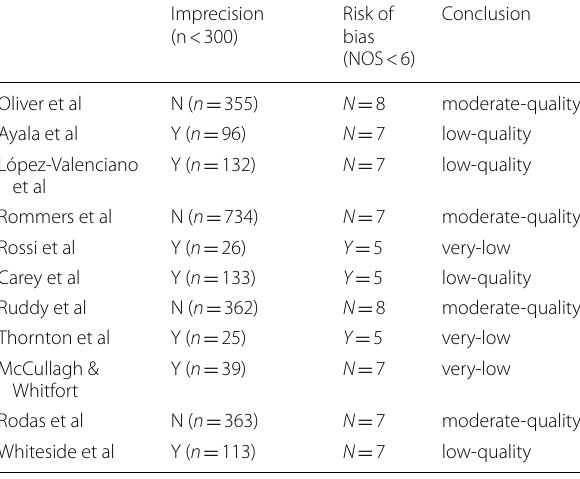
Table 3 Quality of Evidence according to GRADE [18] Imprecision (n <